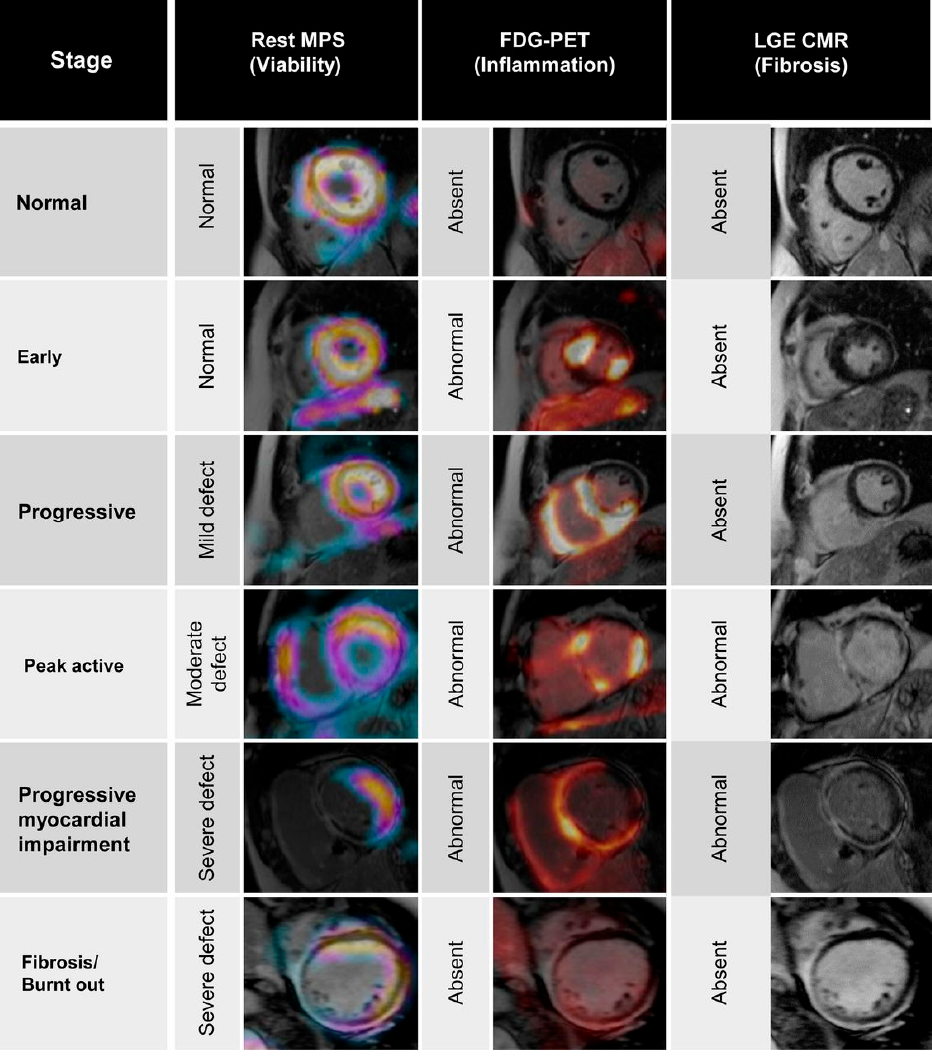
Figure 7. Staging of cardiac sarcoidosis using resting myocardial perfusion scintigraphy (MPS), FDG-PET and LGE-CMR. MPS shows increasing size of scarring as the disease advances. FDG-PET shows a heterogeneous pattern of inflammation in the intermediate stages, with exception to burnt-out stages in which there is no FDG uptake. LGE-CMR demonstrates the fibrotic changes, which is more prevalent in late stage sarcoidosis. Reproduced by Kouranos et al., 2015, by permission of Br. Med. Bull. [139].